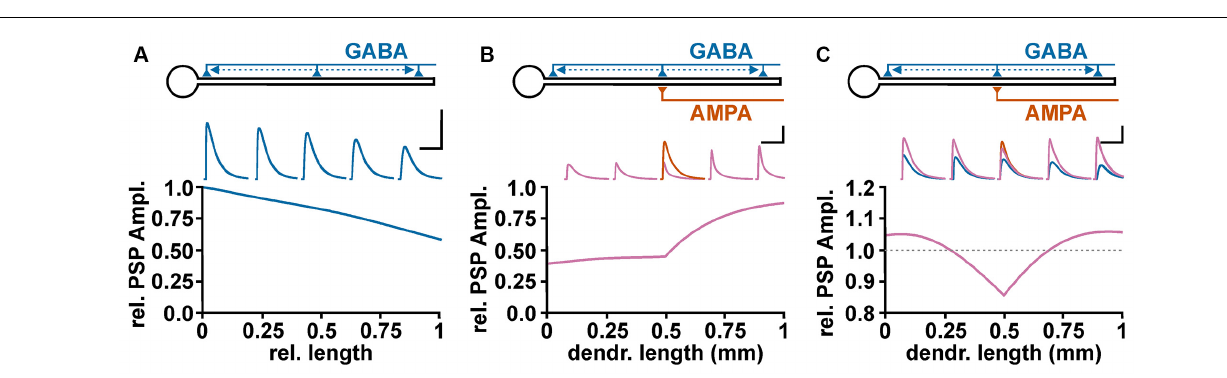
FIGURE 4 | Spatial profile of GABAergic depolarization and GABAergic shunting effects on excitatory glutamatergic inputs. (A) Relative amplitude of GABAergic PSPs, as measured at the soma, upon activation of a depolarizing GABA synapse (E GABA = − 52 mV) at different dendritic positions. The voltage traces above graph illustrate GABAergic PSPs at 0%, 25%, 50%, 75%, and 100% of the dendritic length. Scale bar in (A–C) is 5 mV/500 ms. (B) Profile of the GABAergic shunting effect on glutamatergic inputs, calculated by normalizing the amplitude of the compound PSPs obtained in the presence of GABA (purple traces) to the EPSC amplitude obtained in the absence of GABA inputs (orange trace). In these experiments the shunting effect was isolated by maintaining E GABA at resting membrane potential. Note that GABA synapses located proximally to the AMPA synapse (“on-path”) mediate a stable shunting effect, while for GABA synapses distal to the AMPA synapse (“off-path”) the shunting effect declines rather fast. (C) Effect of a depolarizing GABAergic input (E GABA = − 52 mV) at different positions along the dendrite on the peak compound PSP amplitude during co-stimulation The blue traces represent purely GABAergic PSPs, the orange trace the glutamatergic PSP, and the purple traces the compound PSPs upon co-activation of AMPA and GABA synapses. Note that GABA inputs mediate an inhibitory effect when co-localized with the AMPA synapse, while at more distant on-path and off-path synapses an excitatory effect is